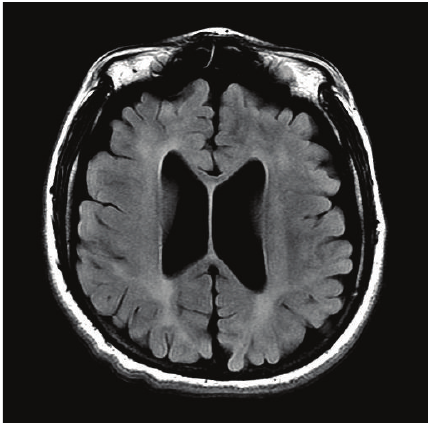
Figure 2: Axial MRI view of the brain at the age of 17 showing bilateraldiffusesymmetricincreasedFLAIRsignalinthesubcortical and periventricular white matter with diffuse atrophic changes involving the supratentorial brain. Axial FLAIR image performed on a 3T MR GE scanner with TR: 9002, TE: 124.7.